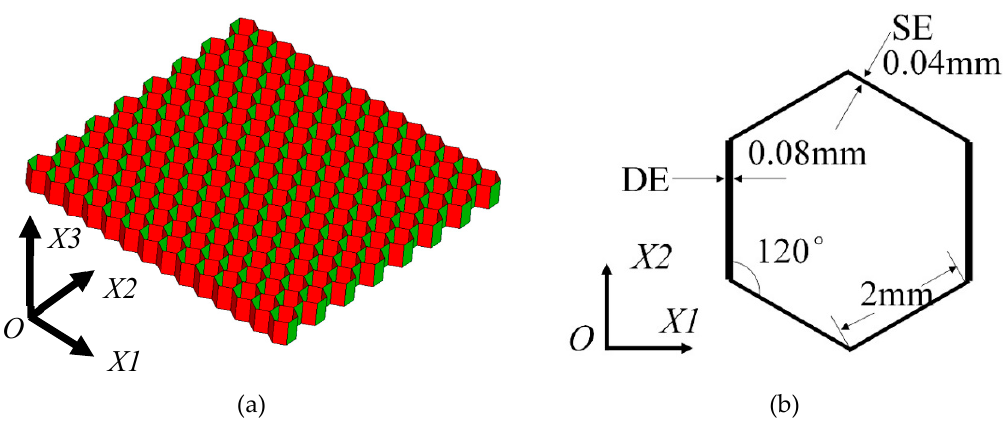
Figure 1. (a) A regular hexagonal honeycomb and (b) the sketch of a single unit cell. Figure 1. ( a ) A regular hexagonal honeycomb and ( b ) the sketch of a single unit